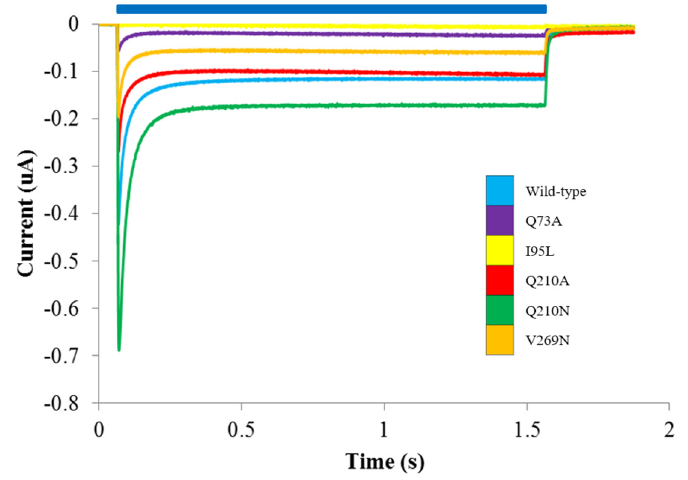
Figure 3. Representative photocurrent traces for RHM ChR2 mutants. Photocurrents were recorded in Na + solution at pH 7.5 at V m = − 100 mV. Blue bar indicates illumination with blue light. WT—blue; Q73A—purple; I95L—yellow; Q210A—red; Q210N—green; V269N—orange.